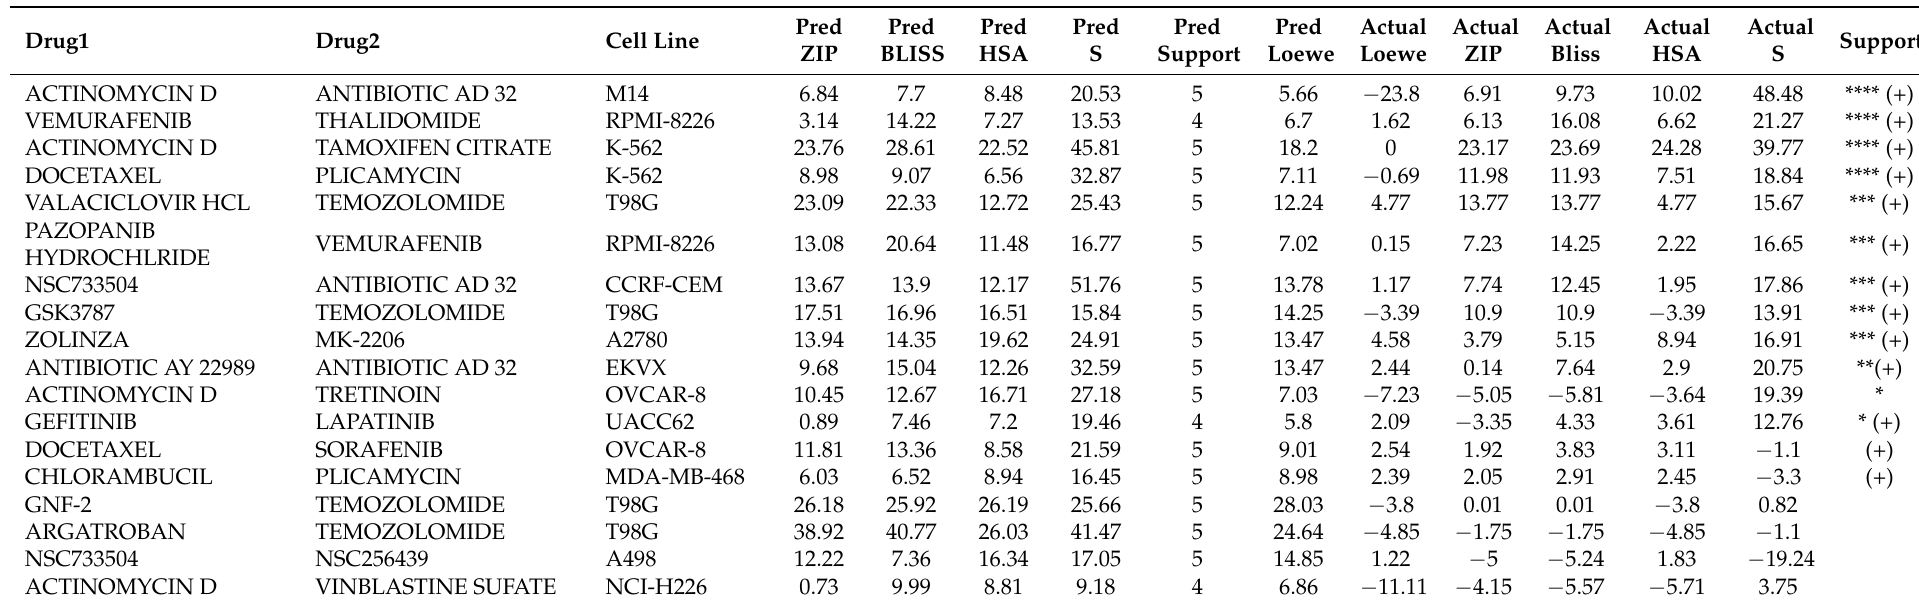
Table 4. The drug combinations with high predictive probabilities which are inconsistent with the actual Loewe